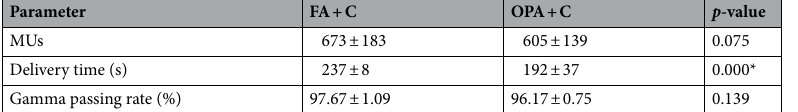
Table 3. The MUs and delivery time in FA + C and OPA + C plans. FA + C full arcs plans with constraints, OPA + C optimal arcs plans with constraints, MU monitor unit, s second. *Represents significant difference (p <